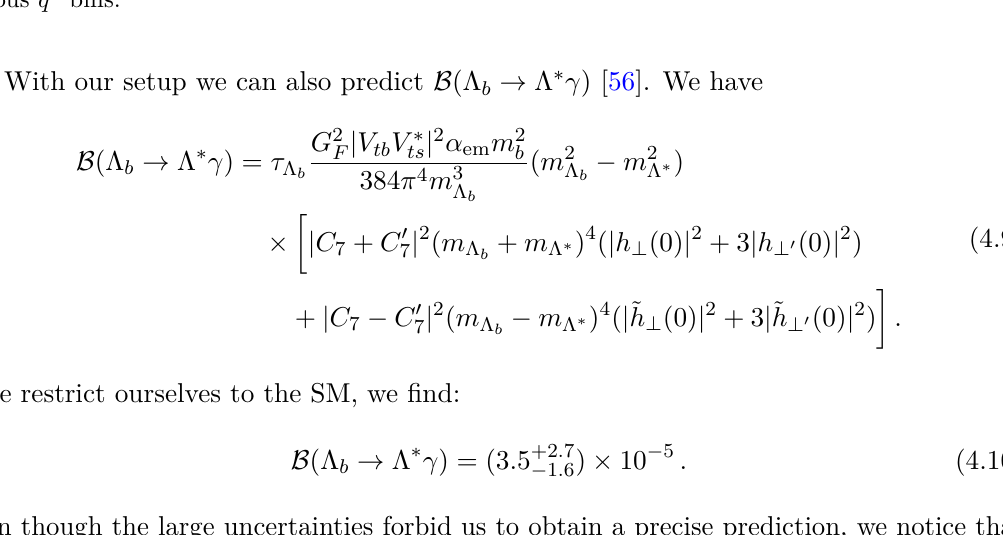
Table 5 . Predictions of the integrated branching ratio and forward-backwards lepton asymmetry in various q 2